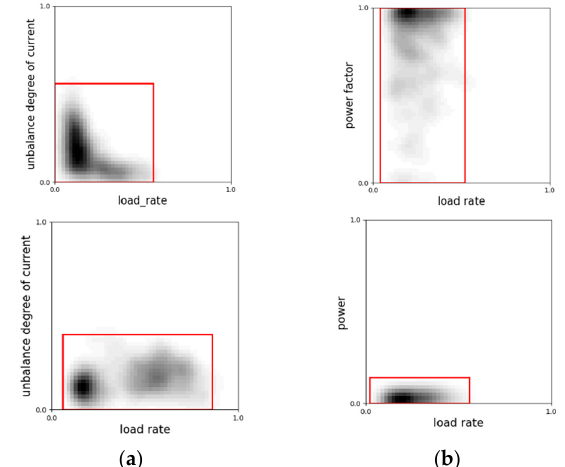
Figure 6. ( a ) The distributions of the 2-D points (load rate, current unbalance degree) from a normal (upper) and an abnormal (lower) customer. ( b ) The distributions of 2-D points (load rate, power factor) and (load rate, power) from the same abnormal user. The ranges are marked with red bounding boxes. Normally, the unbalance degree decreases as the load rate grows as shown in the left in ( a ). As the current on three phases grows, small disturbance would not have much effect on it. So the unbalance degree would turn low and steady. The right figure contradicts this fact. In ( b ), the power factor is 1 for the most of the time, but the power data is nearly zero. This is a typical sign of customers conducting